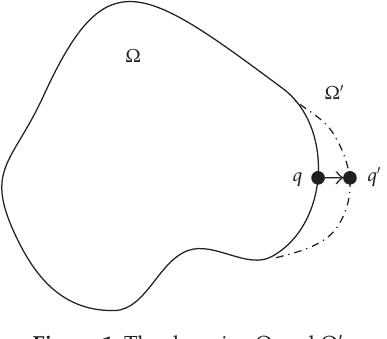
Figure 1: The domains Ω and Ω (cid:14)